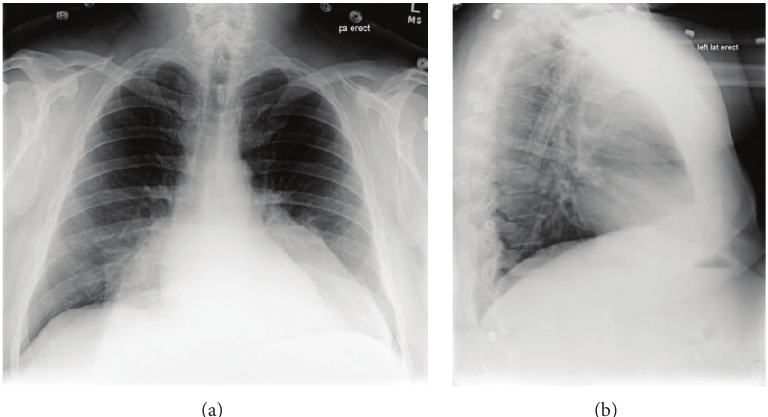
Figure 2: The PA (a) radiograph of the chest reveals a double-density opacity overlying the cardiac silhouette which on lateral (b) radiograph does not appear to localize to the anterior thorax or any compartment of the